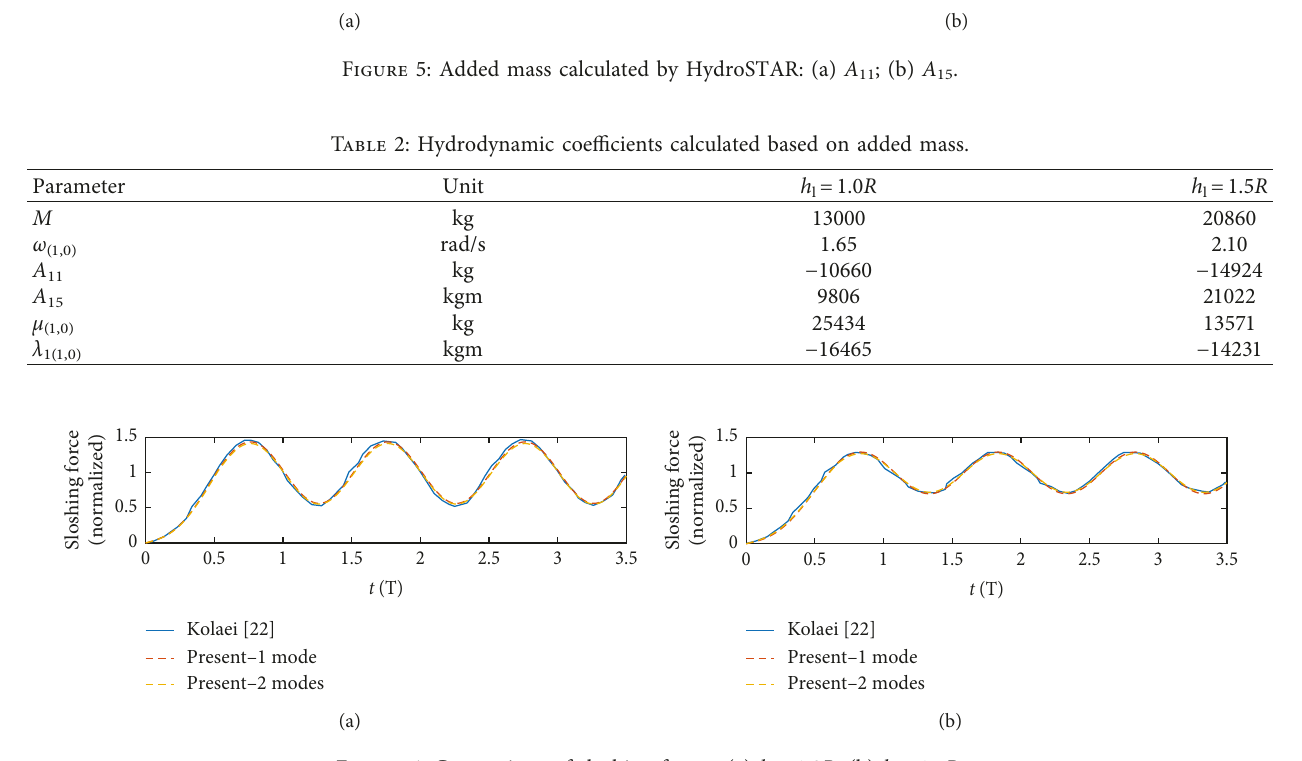
� 1.0 R ; (b) h � 1.5 R l l